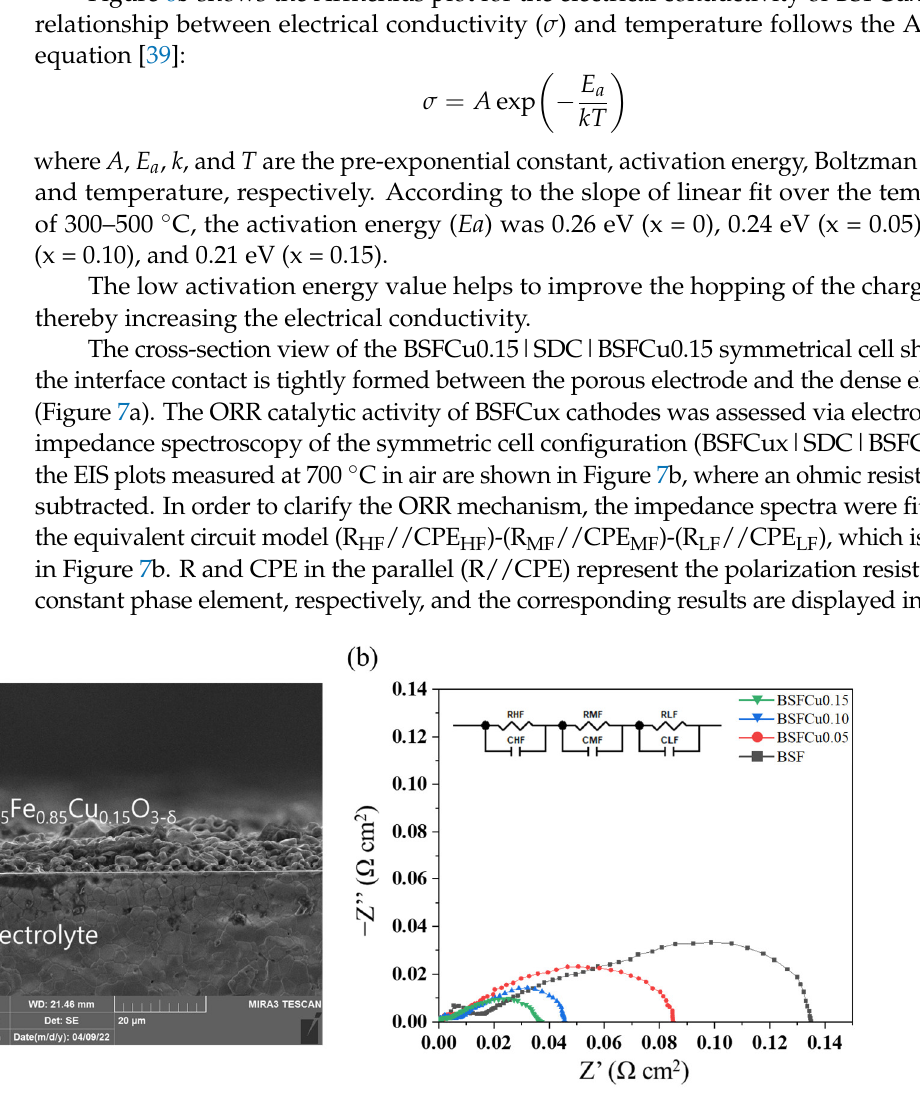
Figure 7. ( a ) Cross-section view of SEM image of the BSFCu0.15|SDC|BSFCu0.15 symmetric cell; ( b ) impedance spectra of the BSFCux|SDC|BSFCux symmetric cell measured at 700 ◦ C in air. Table 3. The Rp fitting results of the Ba 0.5 Sr 0.5 Fe 1 − x Cu x O 3 − δ (x = 0, 0.05, 0.10, 0.15) cathode at 700 ◦ C.